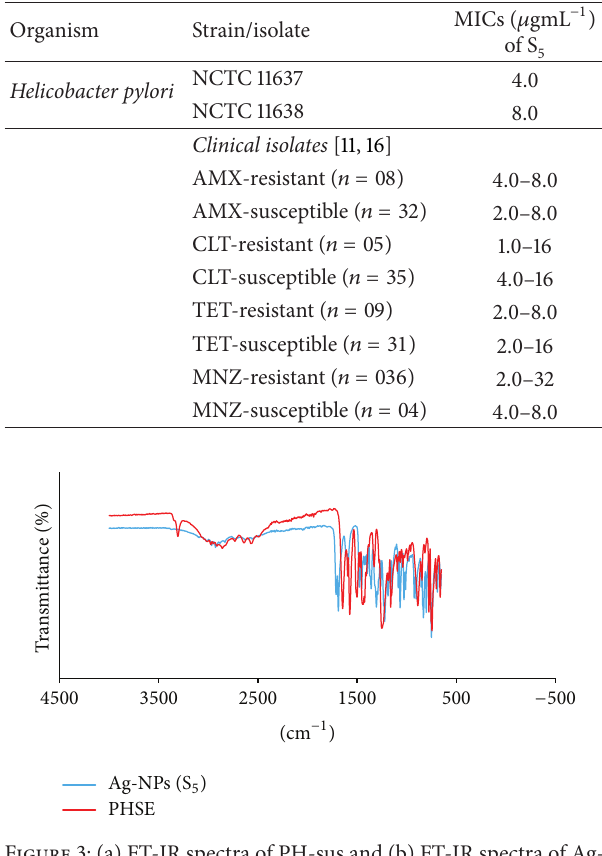
Table 3: In vitro minimum inhibitory concentration of S reference strains and antibiotic-resistant and antibiotic-susceptible local isolates of H. pylori .